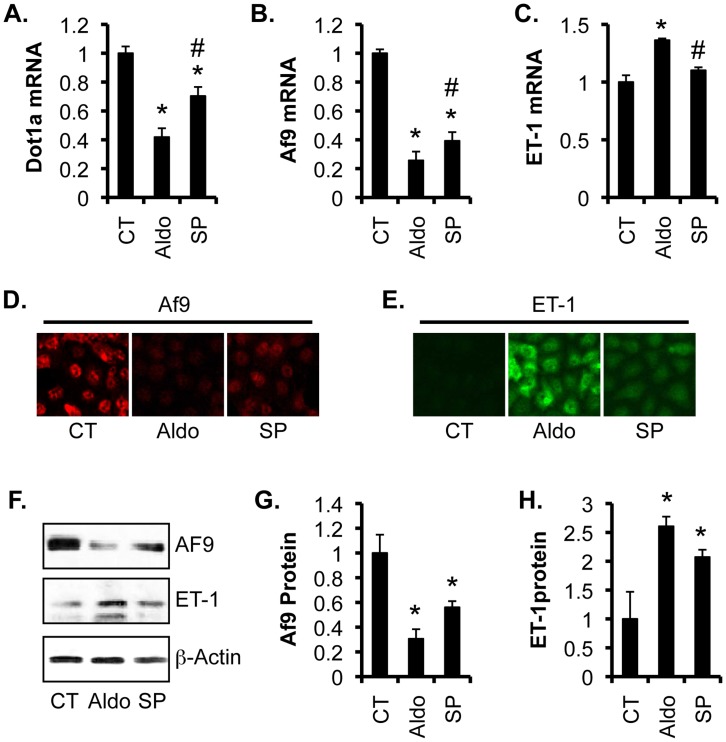
Spironolactone partially reversed the effects of aldosterone on expression of Dot1a, Af9, and ET-1 in NRK-52E cells.(A–C) NRK-52E cells were treated with vehicle as control (CT), 50 nM aldosterone (Aldo), or 50 nM aldosterone plus 1-h pretreatment with 100 nM spironolactone (SP) for 24 hours, and analyzed as in Fig. 7D–F. n = 3. (D–E) Representative IF images showing Af9 and ET-1 expression. (F) Representative IBs showing expression of Af9 and ET-1. (G–H) The intensity of each band in F was analyzed as in Fig. 5E–F. n = 3. In all cases, *P<0.05 vs. CT. #P<0.05 vs. Aldo.